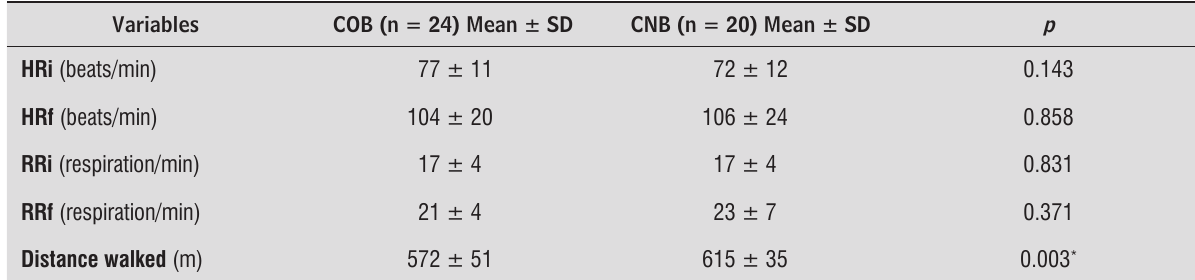
Table 2 - Comparison of the obtained results in the 6 MWT between groups